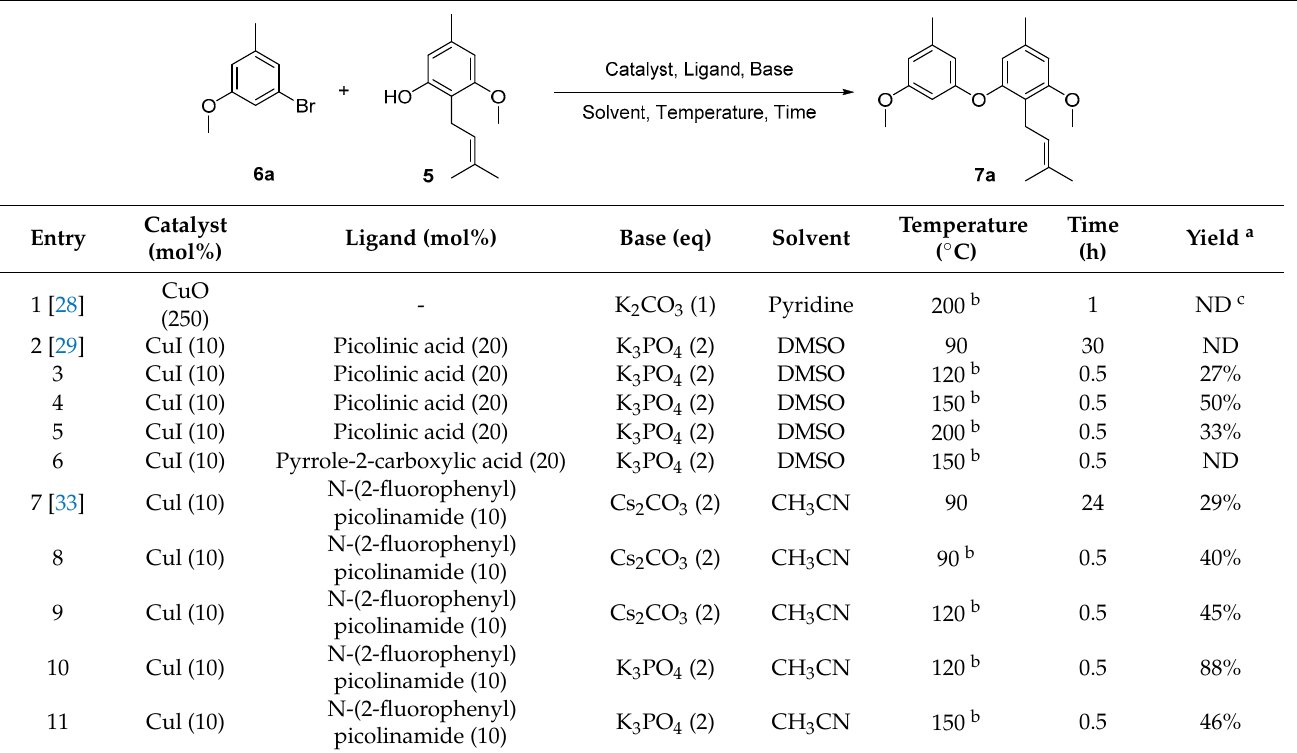
Table 1. Optimization of Cu-catalyzed diaryletherification.